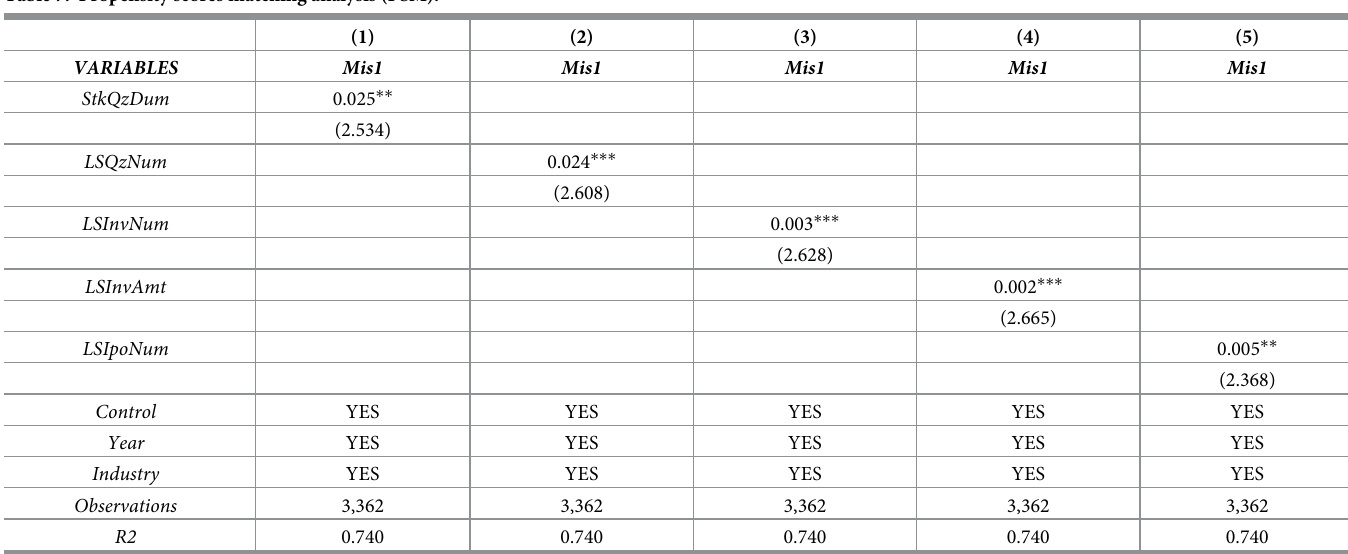
Table 7. Propensity scores matching analysis